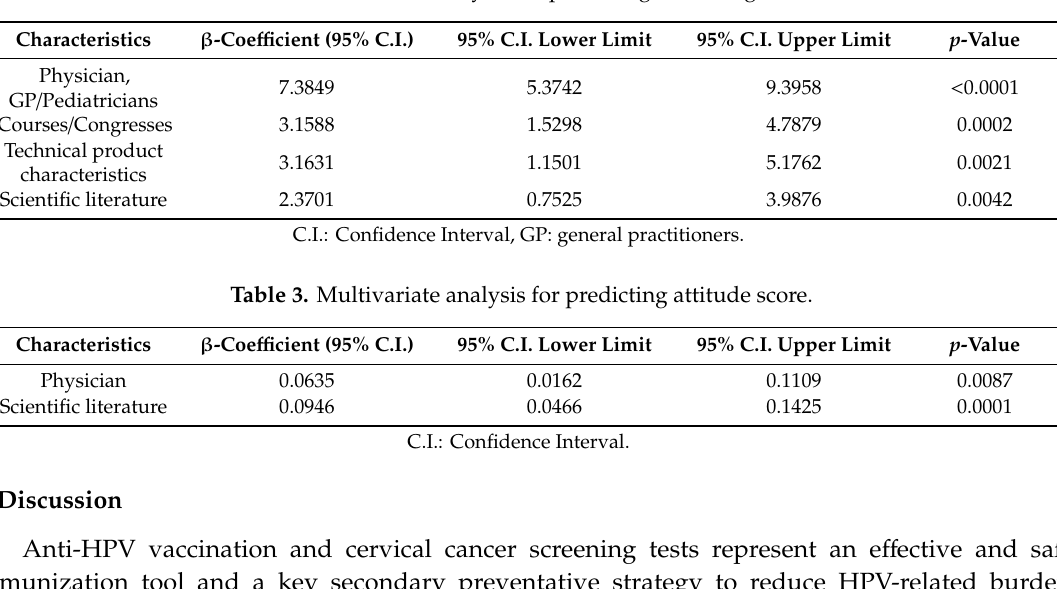
Table 2. Multivariate analysis for predicting knowledge score.